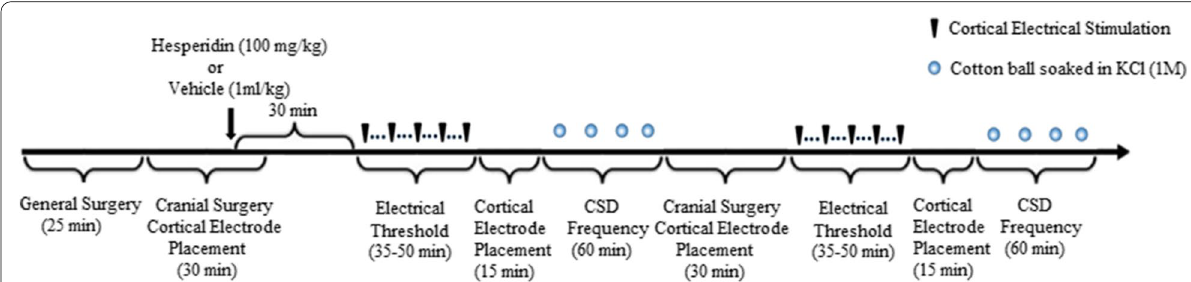
Fig. 1 Experimental timeline to test the effect of hesperidin or its vehicle on electrical CSD threshold and CSD frequency. All symbols are defined on the right upper